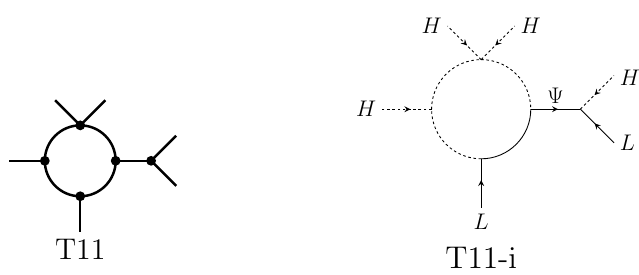
Figure 9 . Topology T11 to the left: the only topology for which a genuine model with no rep- resentations larger than triplets exist. The only genuine diagram for this topology is shown on the